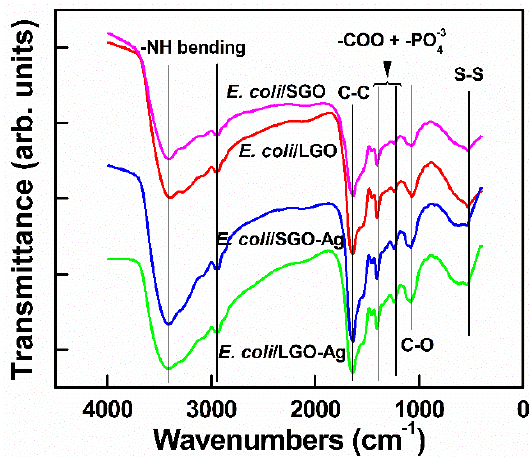
Figure 11. Fourier transform infrared spectroscopy (FTIR) characterizations of E. coli treated with ~100 nm GO, >1 µm GO, ~100 nm GO–Ag NPs and >1 µm GO–Ag NPs.